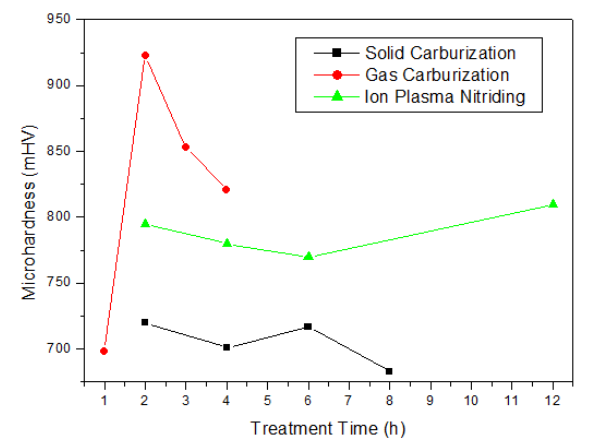
Figure 5 – Micro-scale superficial hardness as a function of treatment time for all the samples